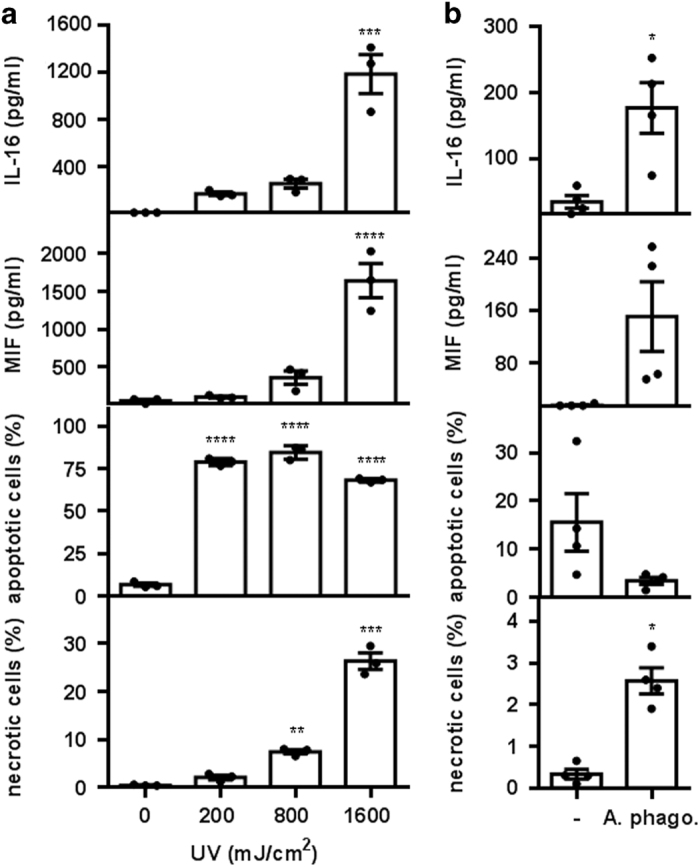
IL-16C release upon treatments inducing secondary necrosis of neutrophils. (a) Neutrophils were irradiated with 0, 200, 800 and 1600 mJ/cm2 UV light (256 nm). After 6 h of incubation at 37 °C, the supernatants were analyzed with ELISA for released IL-16 and MIF. Neutrophil viability was assessed with flow cytometry using Annexin-V-FLUOS and PI staining. Bars represent the means±S.E.M. of three independent experiments (*P<0.05; **P<0.01; ***P<0.001, ****P<0.0001 compared with the 0-h sample by one-way ANOVA followed by Holm Sidak multiple comparison correction). Individual data points are shown as black dots. (b) Neutrophils were infected with A. phagocytophilum (A. phago) for 6 at 37 °C. The supernatants were analyzed with ELISA for released IL-16 and MIF, and neutrophil viability was assessed with flow cytometry using Annexin-V-FLUOS and PI staining. Bars represent the means±S.E.M. of four independent experiments (*P<0.05; **P<0.01; ***P<0.001, ****P<0.0001 compared with the uninfected control by paired t-test). Individual data points are shown as black dots.